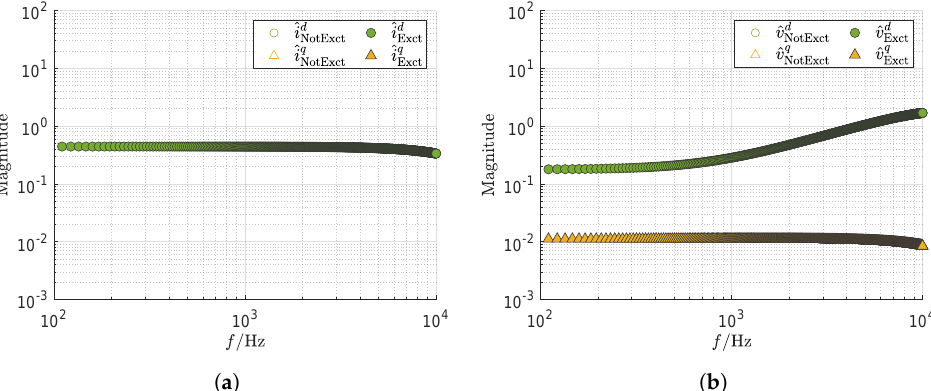
Figure 12. Measurement of the ideal impedance scenario during excitation of the d -axis. ( a ) Spectrum of the current i meas in the dq domain. ( b ) Spectrum of the voltage v meas in the dq